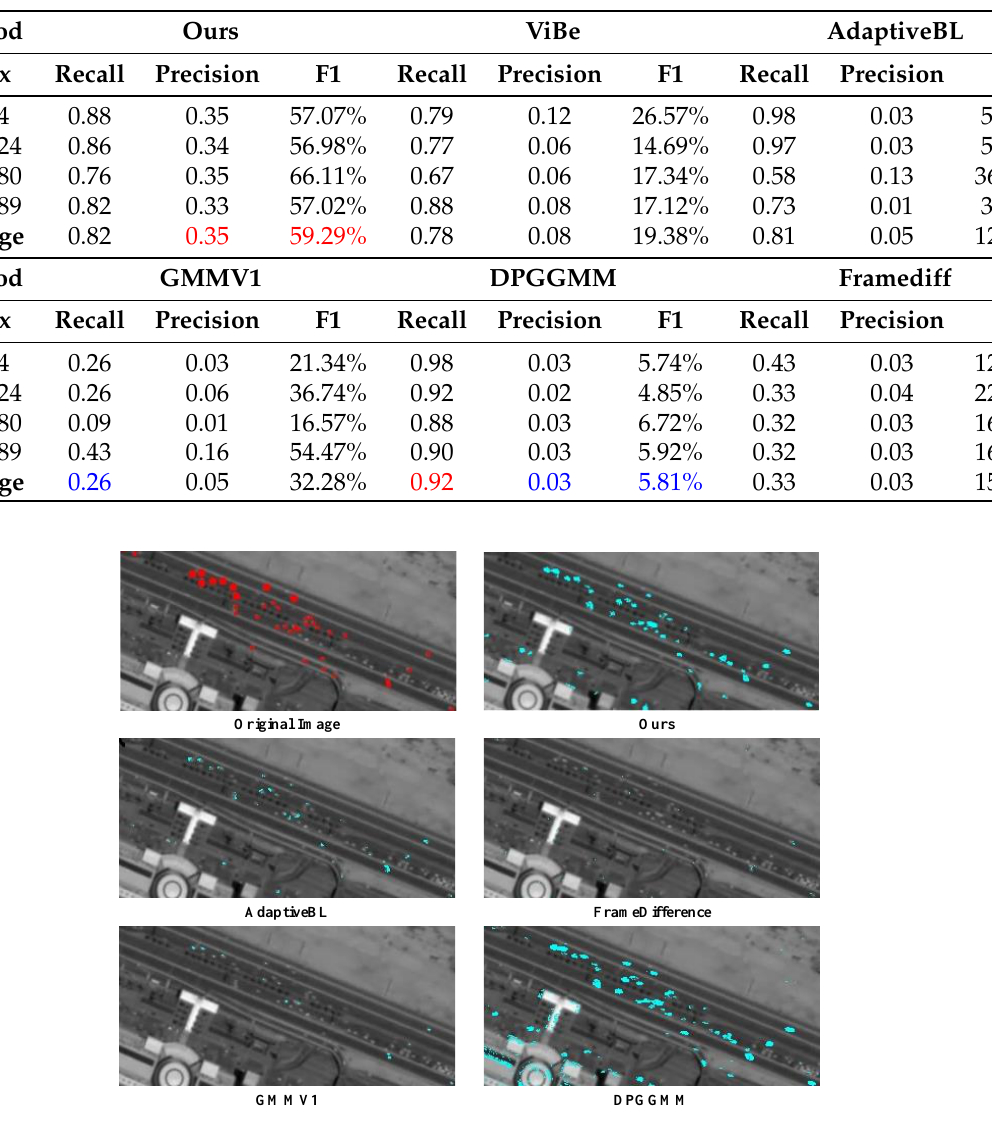
Table 2. The detection results of different methods.